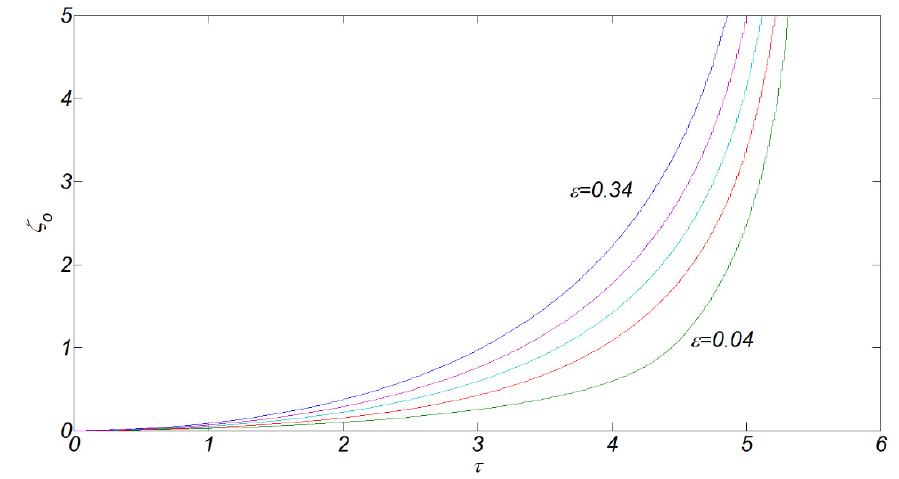
Figure 10. Trajectory of peak period with given wave crest for varying nonlinearity over the sample space ( ς o , τ ).